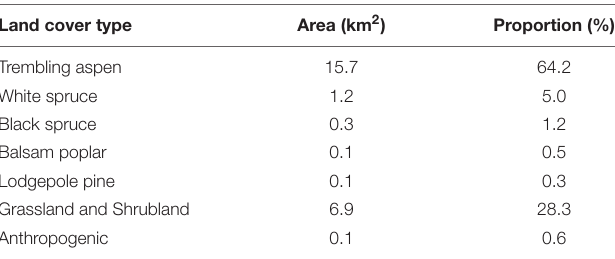
TABLE 1 | Details pertaining to the land cover in the area of interest, derived from the Alberta Vegetation Inventory (Alberta, 2017).